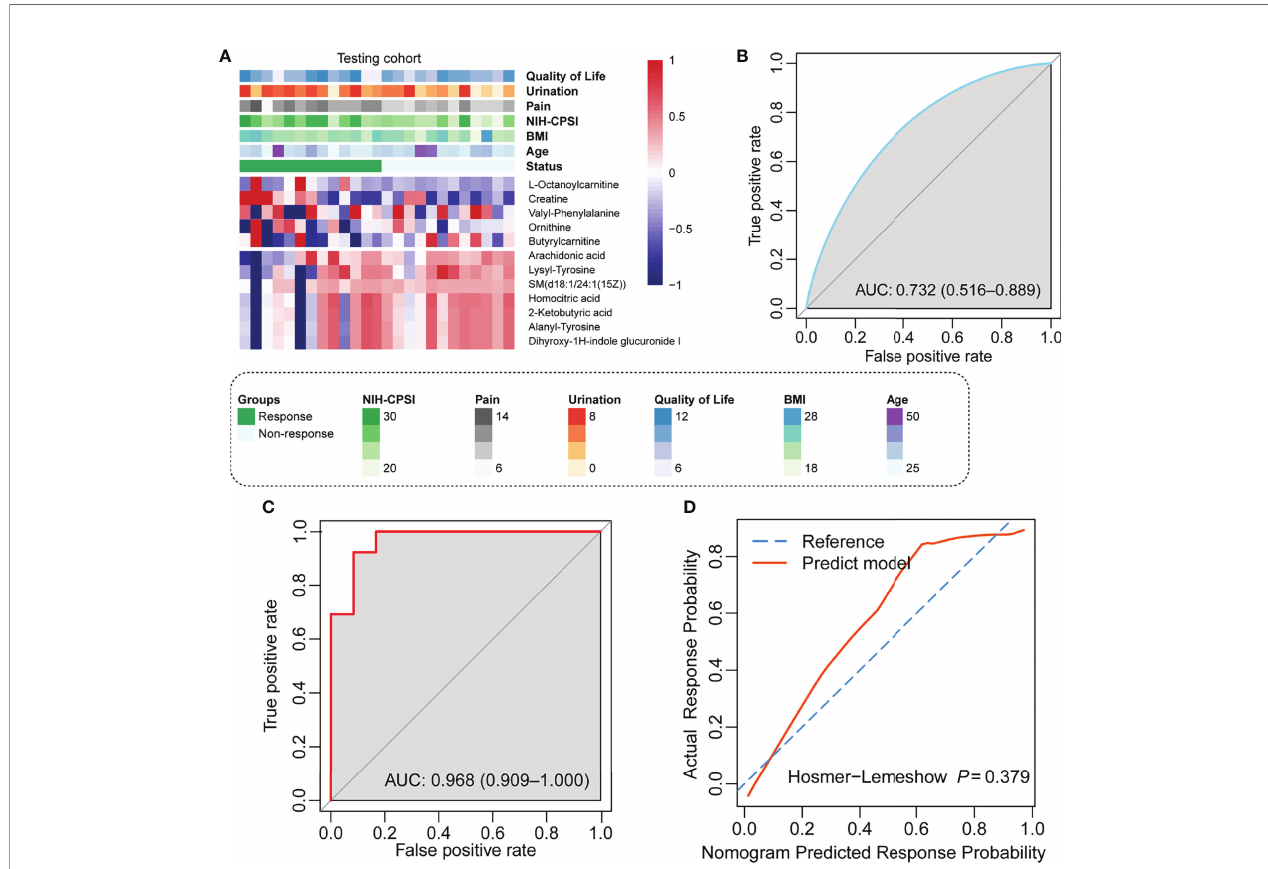
FIGURE 3 | Validation of the prediction nomogram in the testing cohort. (A) Heatmap showing the distribution of 12 selected prediction metabolites and clinical features in the testing cohort; (B) ROC curve showing the prediction value of the metabolism score; (C) ROC curve showing the prediction value of the nomogram; (D) Calibration curve showing the comparison between actual response probability and nomogram-predicted response